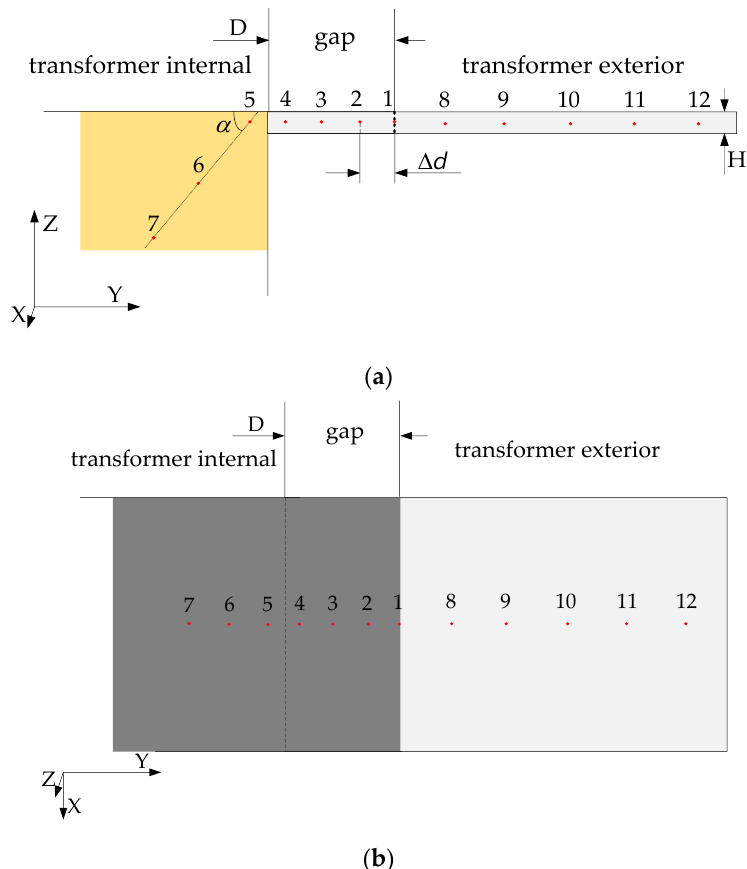
Figure 7. Layout of the detection point: ( a ) X-axis positive view; ( b ) Z-axis positive view.